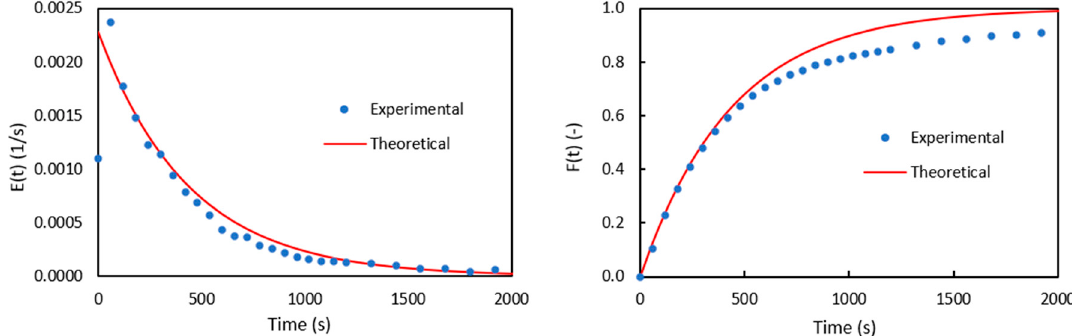
Figure 4. Experimental and theoretical E(t) ( left ) and F(t) ( right ) curves for Test 1.